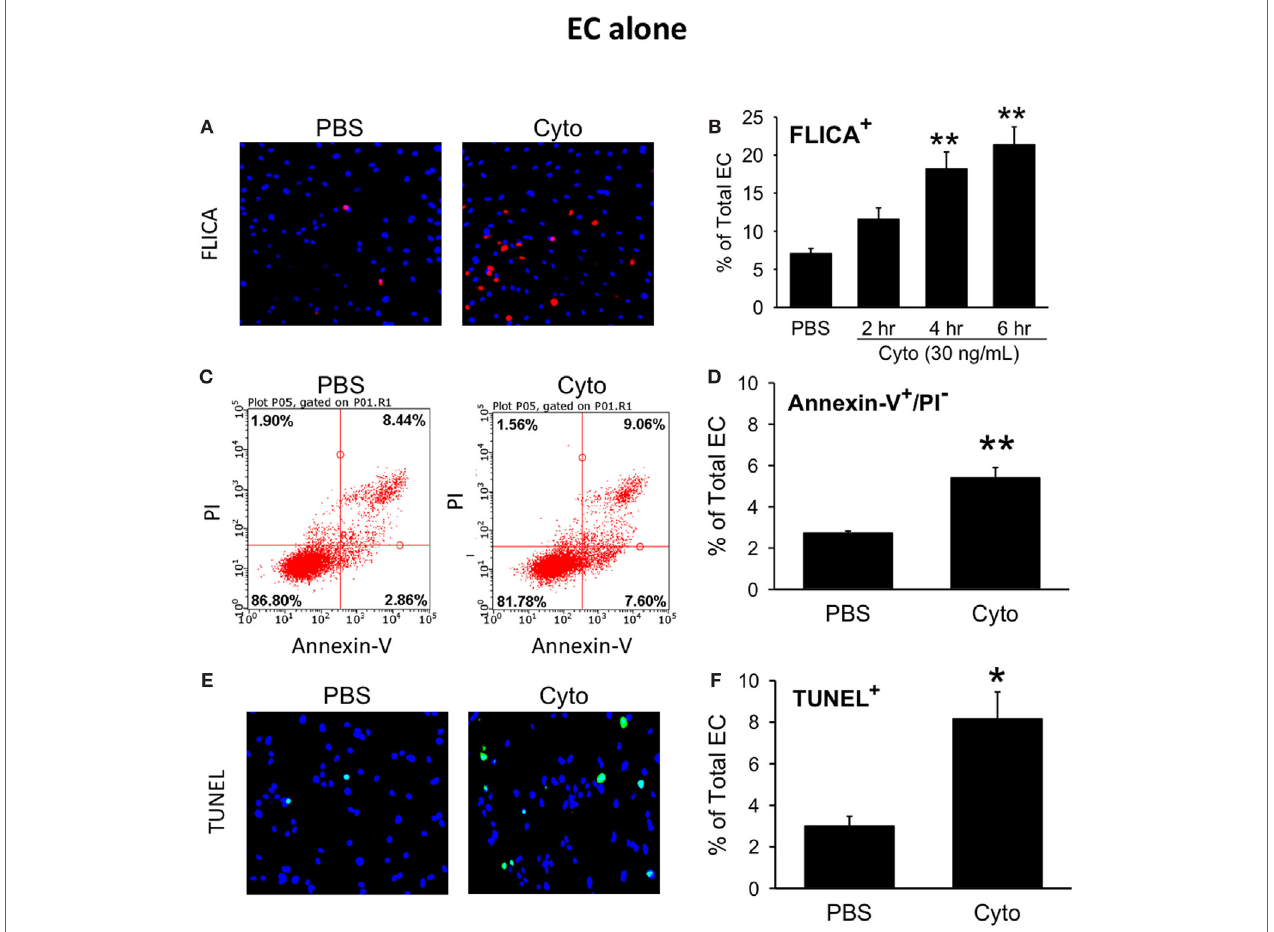
FigUre 2 | Cytomix induces significant human PMVEC apoptosis. Cytomix stimulation of PMVEC cultured alone leads to an increased number of cells stained positive for (a) active caspases [fluorescent inhibitor of caspases (FLICA); red]; (c) loss of cell membrane polarization (Annexin V); and (e) DNA fragmentation [terminal deoxynucleotidyl transferase dUTP nick end labeling (TUNEL); green]. Quantification revealed significant increases in FLICA + cells (B) by 4 h post-cytomix that persisted at 6 h post-cytomix. The number of Annexin-V + /propidium iodide (PI) − cells (D) and TUNEL + cells (F) were also significantly increased by 5 h post-cytomix. * p < 0.05 and ** p < 0.01 compared with respective PBS-treated group (two-way ANOVA or t -test). n =